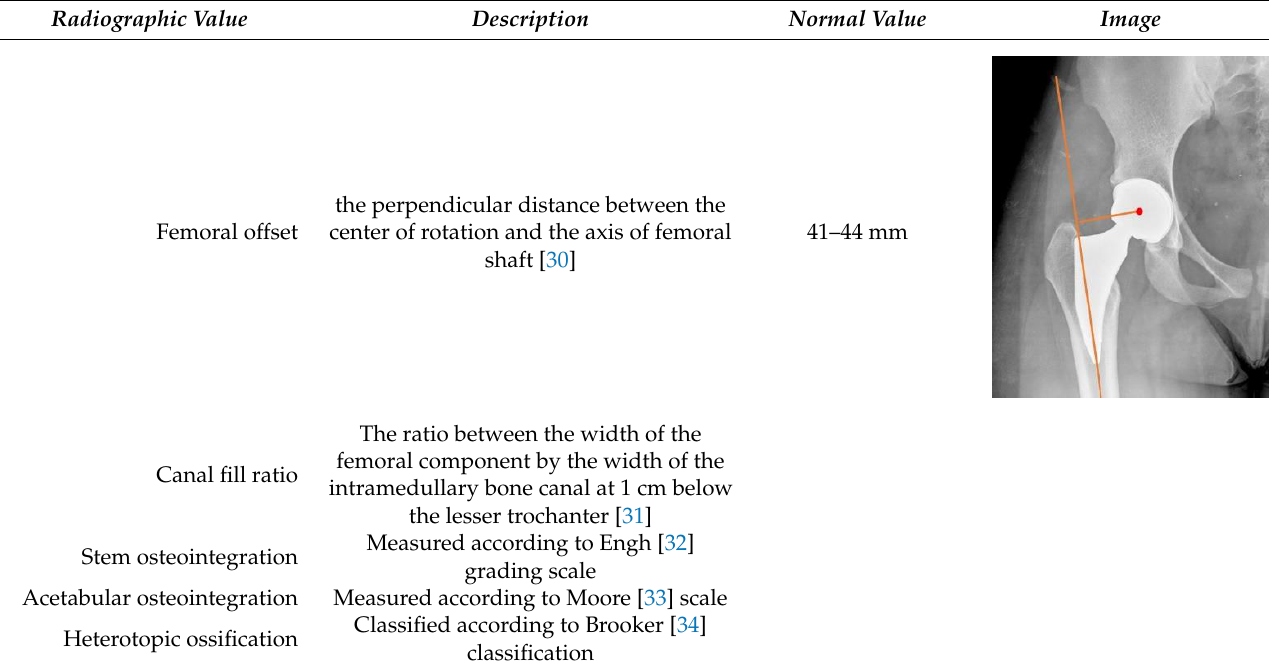
Table 2. Patient characteristics and baseline variables. All results are expressed as crude numbers for dichotomous variables and as mean ± Standard Deviation for continue